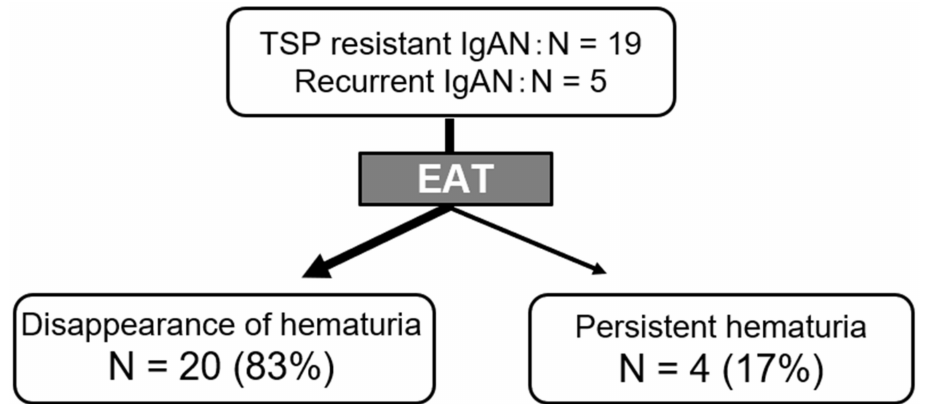
Figure 12. Effects of epipharyngeal abrasive therapy on hematuria in patients with IgAN with TSP resistant or relapsed